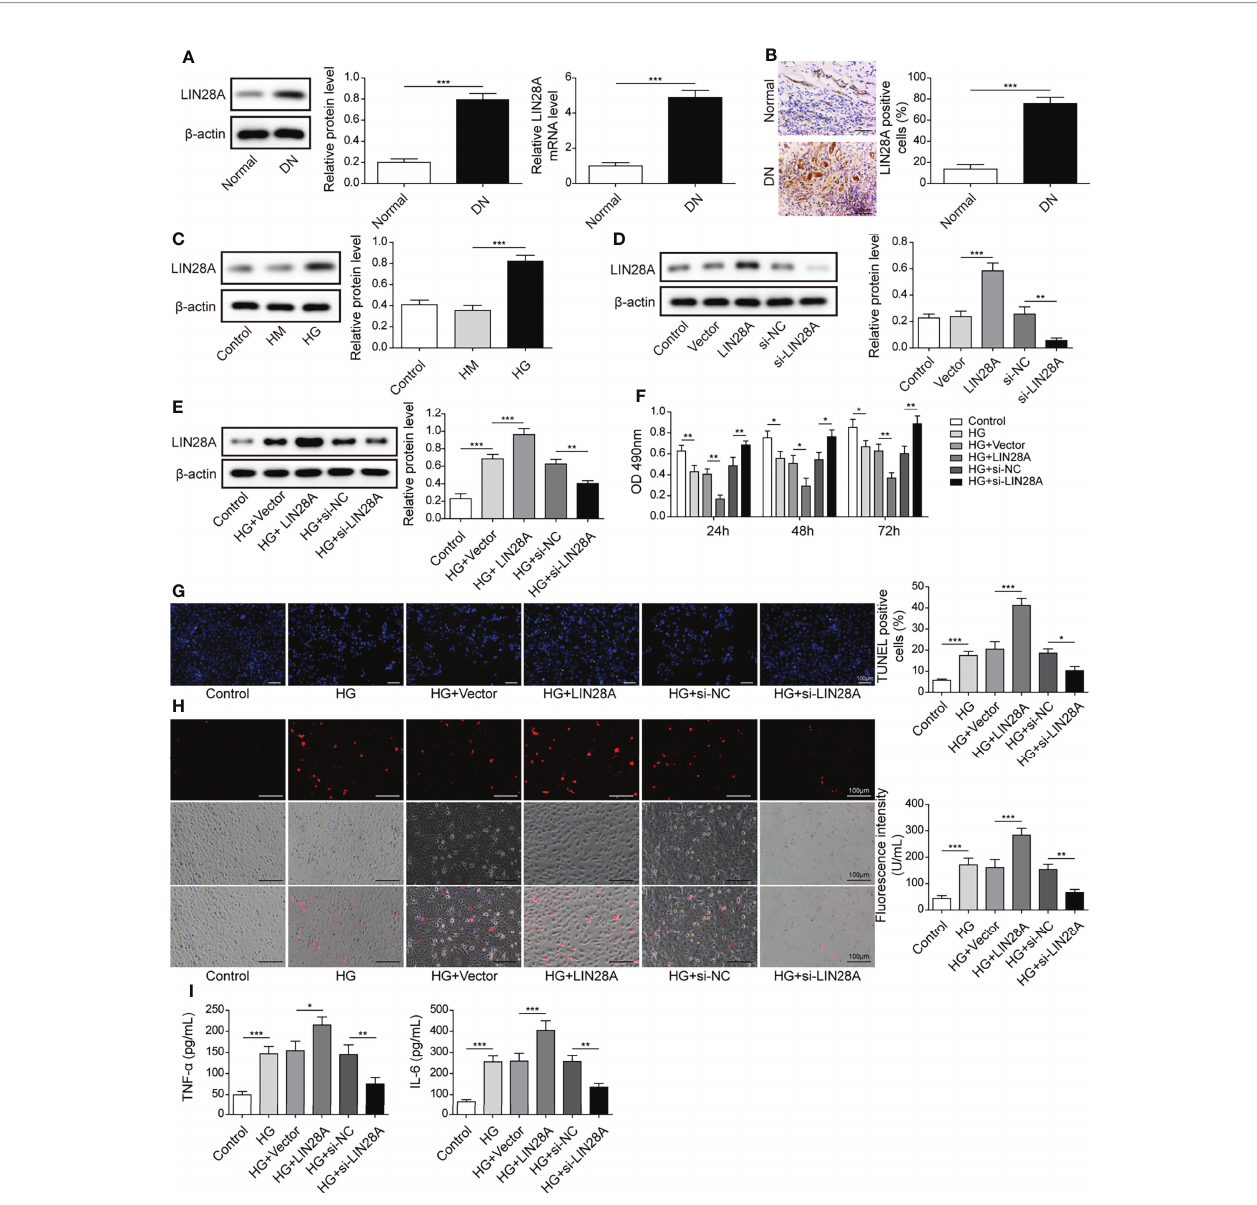
FIGURE 2 | LIN28A enhanced HG-induced cell apoptosis, ROS generation and in fl ammatory cytokine secretion. (A) The expression of LIN28A in DN and normal tissues was analyzed by qRT-PCR and western blotting (n=6). (B) IHC staining of LIN28A. (C) Protein levels of LIN28A in HK-2 cells treated with NG, HM or HG were examined by western blotting (n=4). (D) Western blotting analysis of LIN28A in HK-2 cells (n=4). HK-2 cells were transfected with vector, oe-LIN28A, si-NC or si-LIN28A and subsequently treated with HG for 48 h (E) LIN28A was detected using western blotting (n=4). (F) Cell viability was examined by MTT assays (n=4). (G) TUNEL staining (TUNEL, green. Scale bar=100 µM) were examined. (H) Cellular ROS levels were examined by a fl uorometric ROS sensor (red, n=4. Scale bar=100 µM). (I) Secretion of TNF- a and IL-6 into culture supernatants (n=4). * P < 0.05, ** P < 0.01 and *** P <